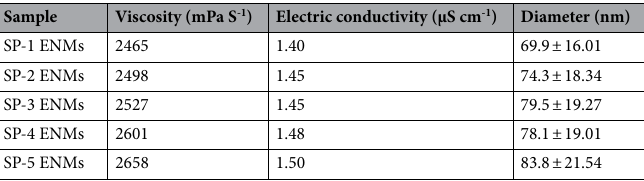
Table 2. Physical properties of the SP